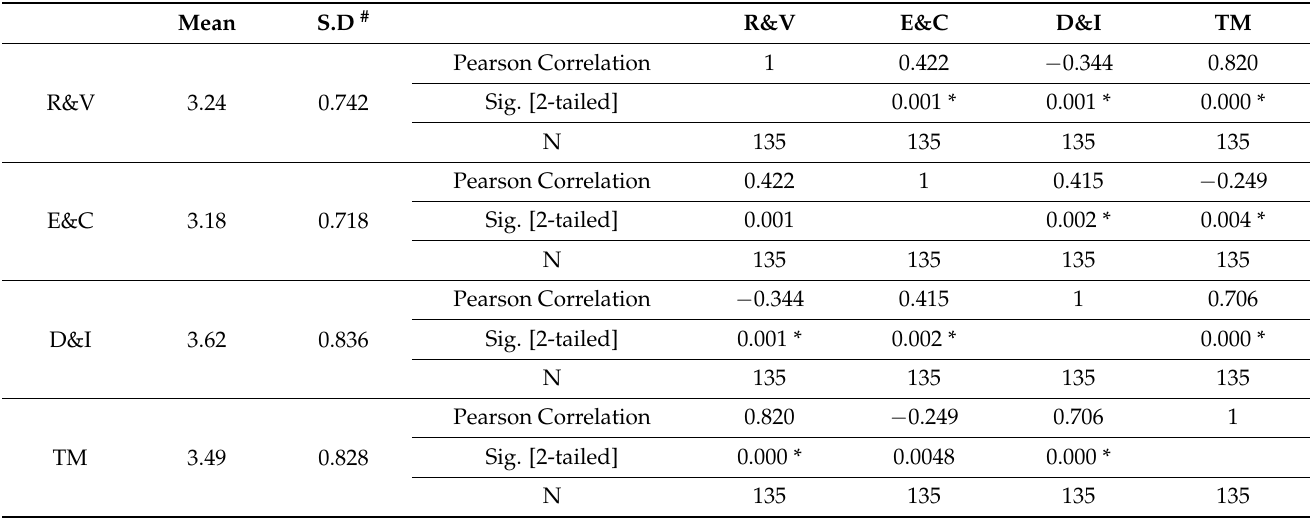
Table 1. Correlation Coefficients between Variables.